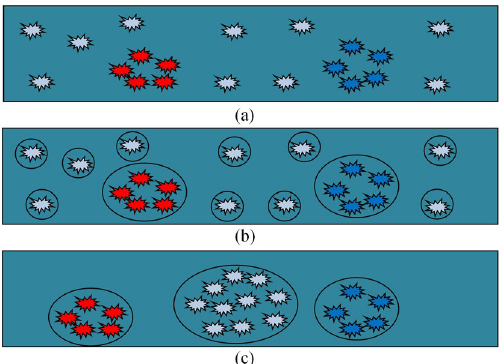
Fig. 2 Partitioning illustration. a Measurement set. b A partition generated by the distance partitioning or the GD partitioning. c Partition should be used in the general CPHD filter. The clutter measurements are merged to a single